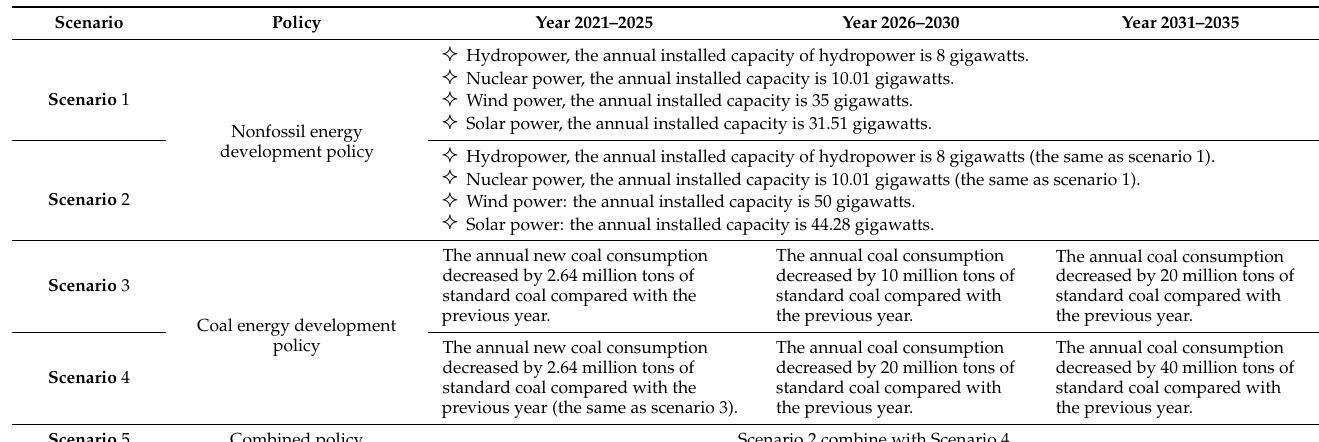
Table 4. Scenario settings for China’s energy policy simulations.